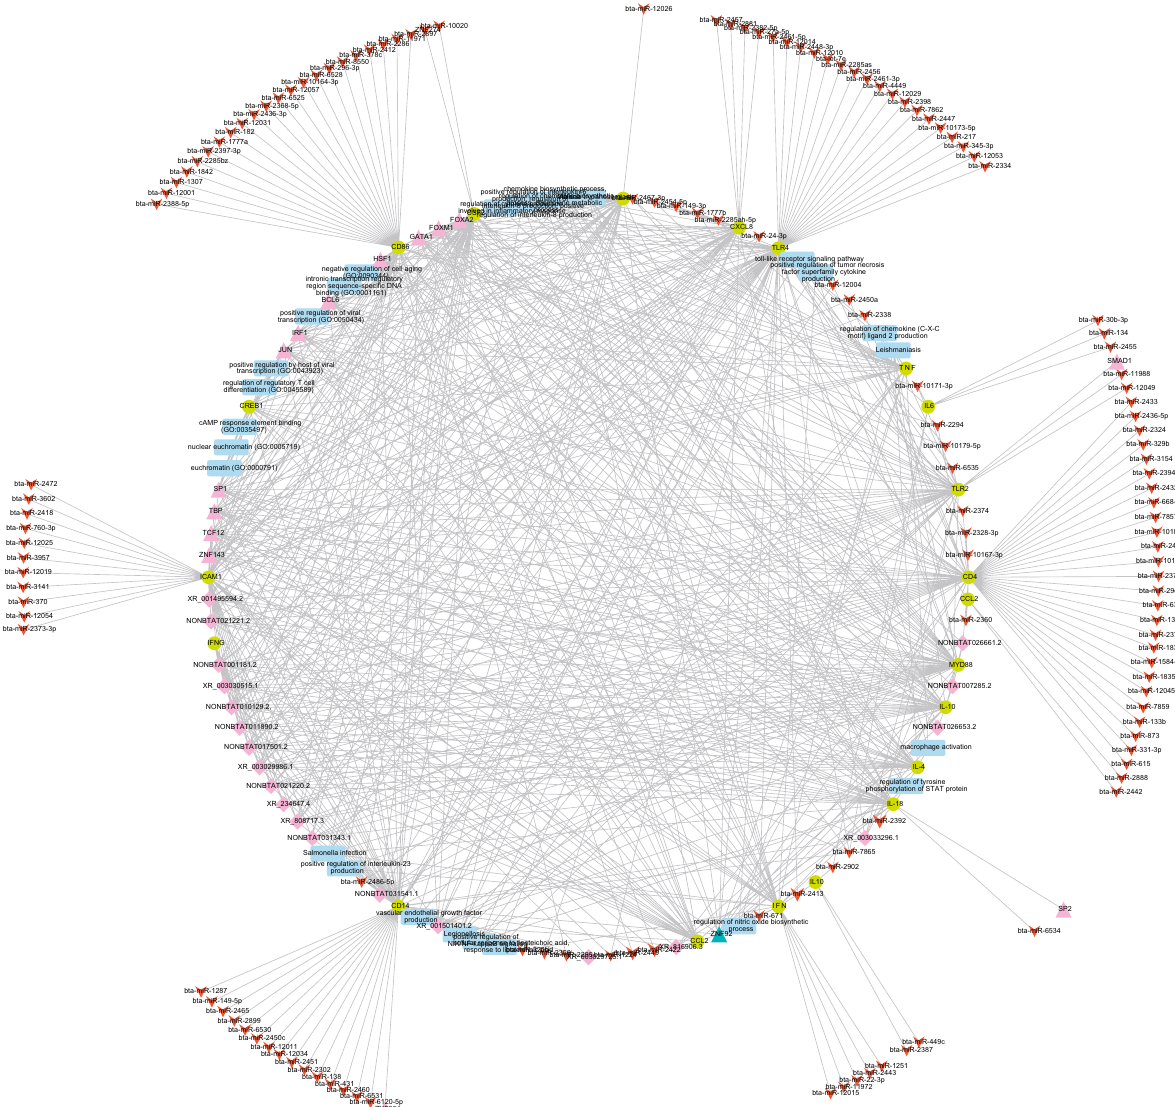
Figure 11. A network incorporating miRNA, lncRNA, TFs, target genes, and gene ontologies. The red arrowheads represent miRNA; purple diamonds represent lncRNA; teal triangles represent TFs; green circles represent target genes, and the blue rectangles biological processes, molecular functions, cellular components, and pathways (Cytoscape version 3.7.2; https:// cytos cape.